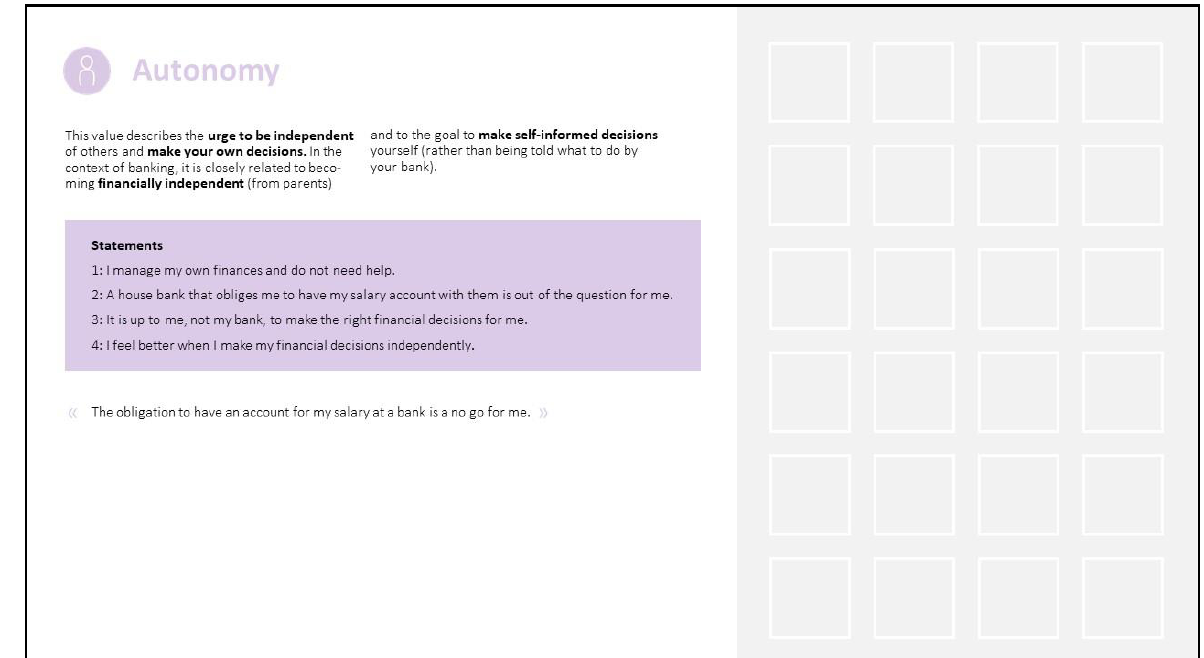
Figure 4. Need Poster employed to help workshop participants to understand and reflect on the need “Autonomy”.